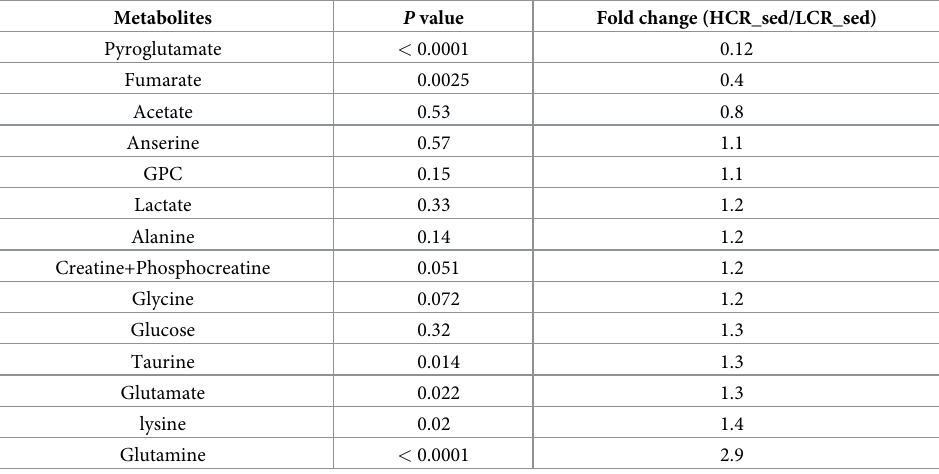
Table 2. Univariate analysis between 9 months LCR sed and 9 months HCR sed.